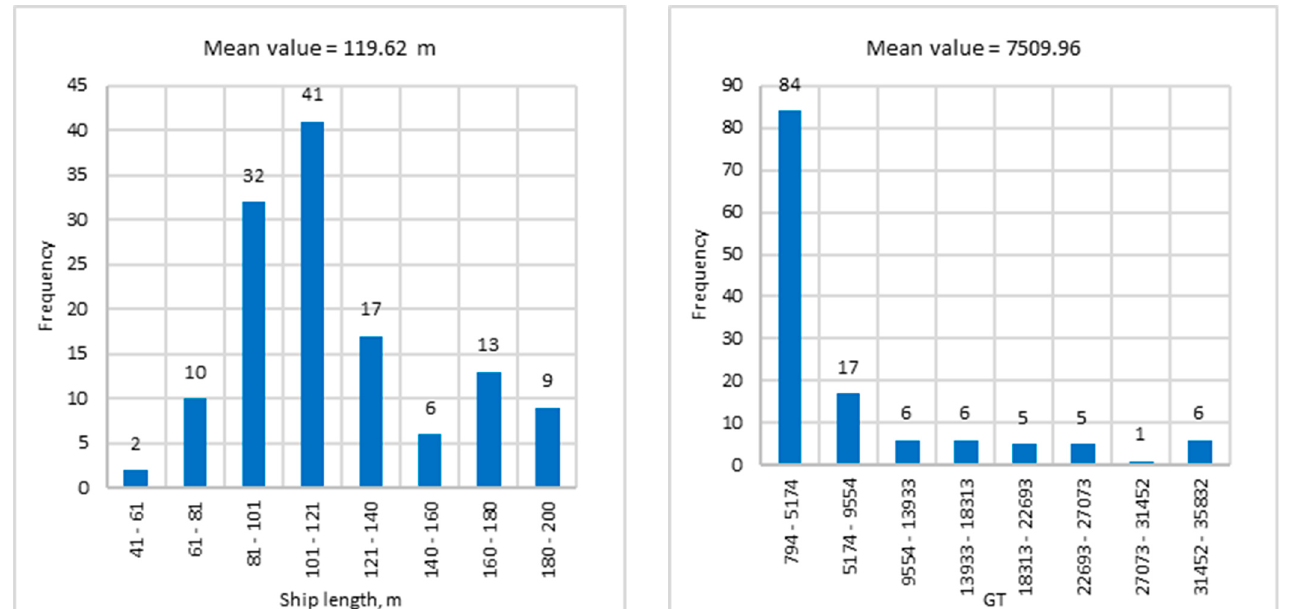
Figure 2. Ship length ( left ) and GT ( right ).